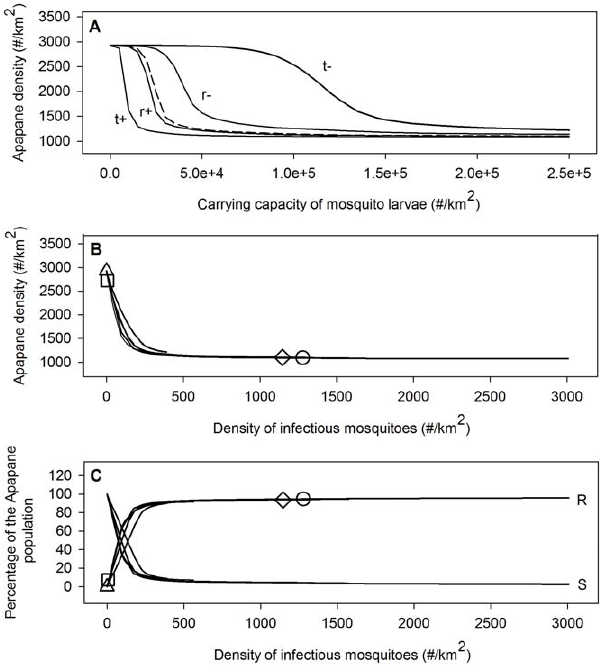
Figure 5. The mean annual densities of Apapane at mid- elevation as a function of larval carrying capacity and density of infectious mosquitoes. The bottom graph shows the percentage of Apapane in the susceptible (S, dotted line) and recovered stage (R, solid line) as a function of the density of infectious mosquitoes for different climate scenarios. The dashed line represents a climate with a mean annual temperature of 17 u C and an average yearly rainfall of 3000 mm. The other climate scenarios are derived from this scenario by increasing or decreasing the daily temperatures and rainfall (see text). The mean annual temperatures and average yearly amounts of rainfall for these scenarios are 15.5 u C and 3000 mm (t 2 ), 18.5 u C and 3000 mm (t + ), 17 u C and 2000 mm (r 2 ) and 17 u C and 4000 mm (r + ). The markers in the two bottom figures indicate values for the biocomplexity field sites: circle=Waiakea, diamond=Cooper, square=Crater and trian- gle=Pu’u.